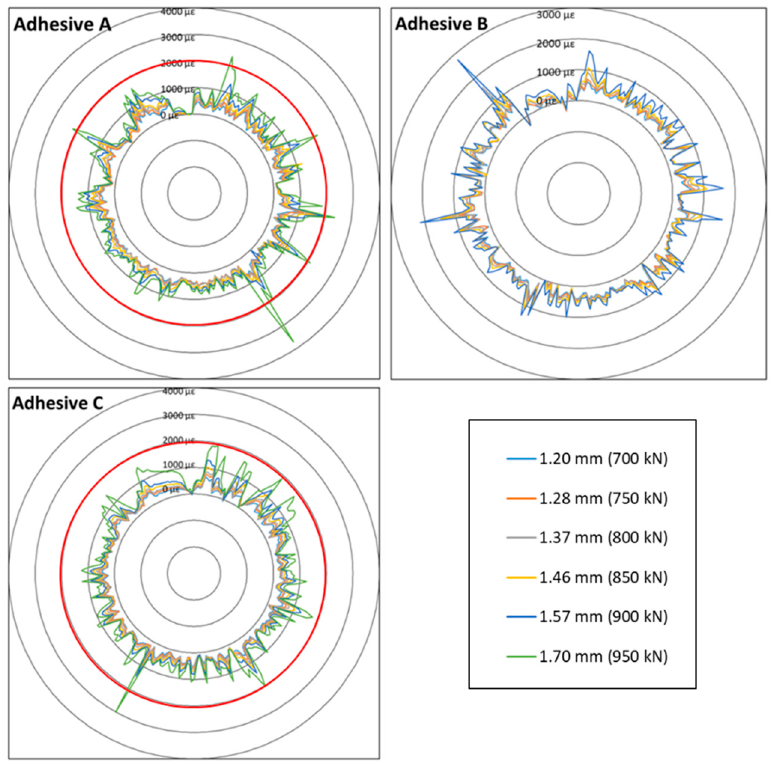
Figure 10. Orthoradial strain profiles around the concrete cylinder, collected at different levels of compression load by DOFS bonded with the three different adhesives (A, B, and C).